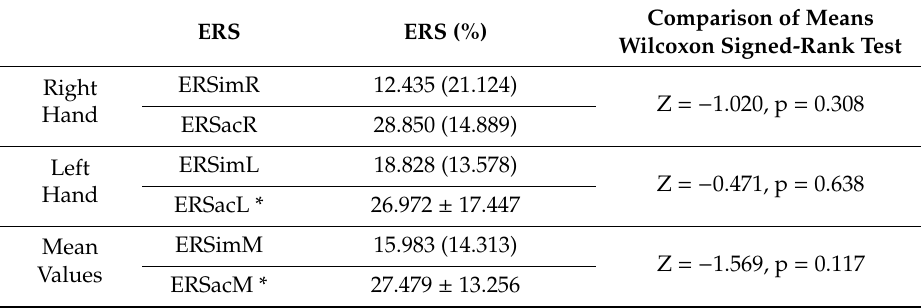
Table 3. Analysis of the ERS data